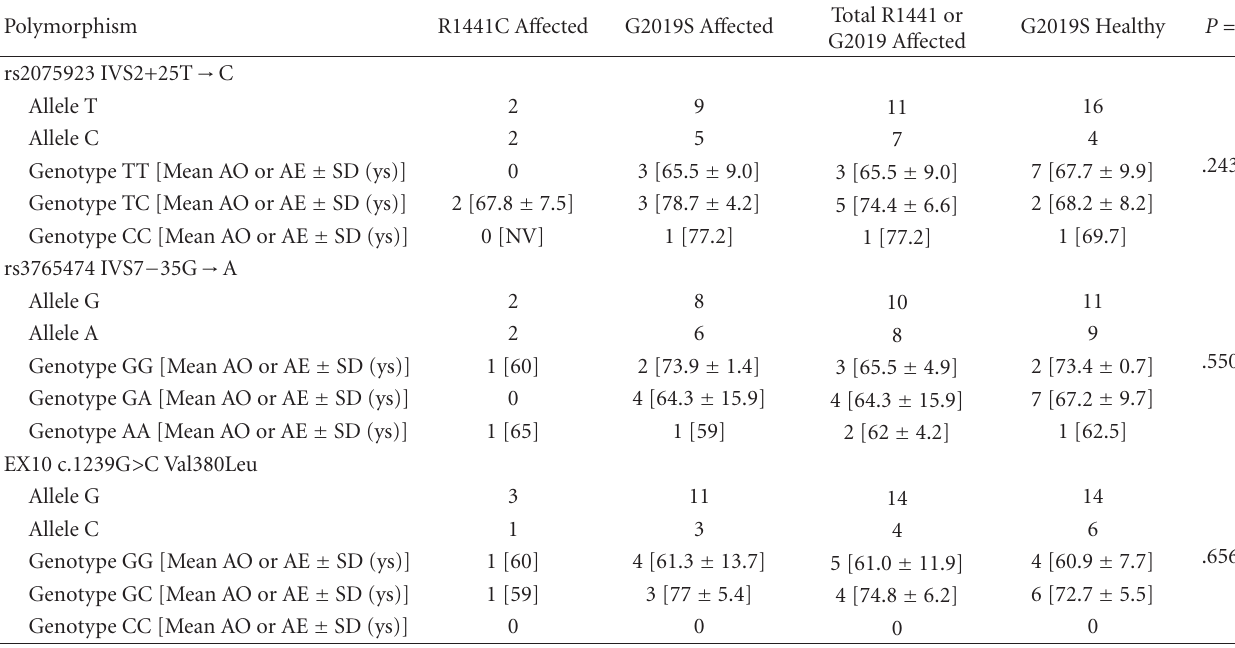
Table 3: Allele and genotype frequency distribution of three single-nucleotide polymorphisms of the parkin gene in carriers of LRRK2 mutations (R1441C or G2019S) with or without